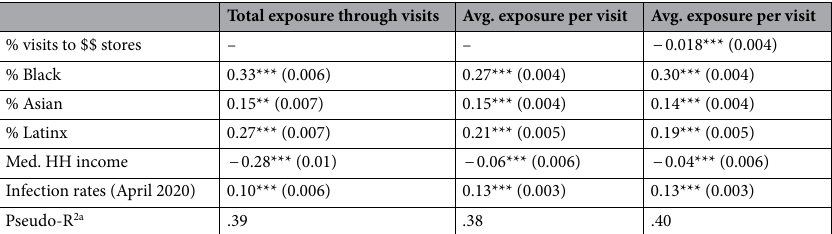
Table 3. Parameter estimates from regression models testing the relationship between race and socioeconomic status and exposure to infection from grocery store visits in April 2020, taking into account strategies for diminishing exposure. Sample of 2,153 CBGs in metro Boston, MA with population > 250 residents, at least one recorded grocery store visit in April 2020, and values on all other variables. The outcome variables were modeled as a Poisson distribution. All predictor variables scaled before analysis, meaning parameters are an estimate of the likelihood of increase or decrease with each change in 1 SD in the predictor variable. All models also controlled for the same measure in Feb. 2020, total population, population density, total stores or $$ or $ stores within a 15-min drive of the centroid of the CBG (as appropriate per model), % < 18 yrs., % > 65 yrs., and % commuting by car. See SI for all parameters and Methods for variable details. a Reported as McFadden’s pseudo- R 2 .